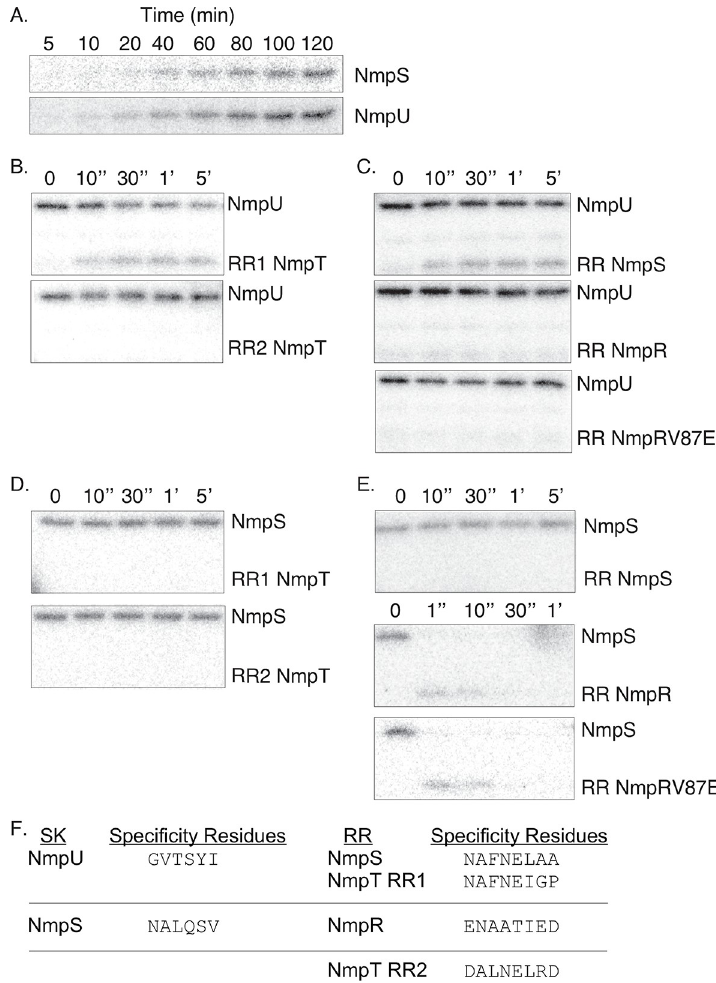
Fig 6. In vitro phosphotransfer in the NmpRSTU multi-component pathway. (A) The kinases NmpS and NmpU autophosphorylate in the presence of ATP- γ P 32 as seen by the accumulation of the radioactive phosphoryl group. NmpU specifically phosphorylates the first receiver domain of NmpT (RR1) and the receiver domain of NmpS (B and C). In contrast, NmpS only phosphorylates NmpR (D and E). Note the rapid kinetics of the phosphorylation of NmpR by NmpS (E). Also, the V87E amino acid change of NmpR does not affect the specificity of the phosphotransfer (C and E). The specificity residues [10, 11, 96] of the SK domains of NmpS and NmpU and the corresponding specificity residues of the receiver domains of NmpR, NmpS, and NmpT further supports the observed phosphotransfer patterns (F).